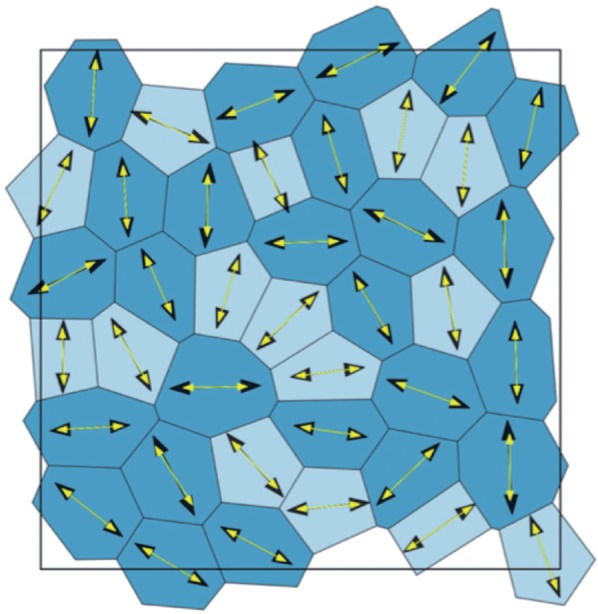
Computational validation of the predicted alignment between principal axis of stress and shape, for \documentclass[12pt]{minimal}
\usepackage{amsmath}
\usepackage{wasysym} 
\usepackage{amsfonts} 
\usepackage{amssymb} 
\usepackage{amsbsy}
\usepackage{upgreek}
\usepackage{mathrsfs}
\setlength{\oddsidemargin}{-69pt}
\begin{document}
}{}$(\Lambda, \Gamma) = (-0.2, 0.1)$\end{document}. The initial cell array was generated using a Voronoi tessellation and then relaxed to equilibrium using periodic boundary conditions. The eigenvectors corresponding the the principal eigenvalue of \documentclass[12pt]{minimal}
\usepackage{amsmath}
\usepackage{wasysym} 
\usepackage{amsfonts} 
\usepackage{amssymb} 
\usepackage{amsbsy}
\usepackage{upgreek}
\usepackage{mathrsfs}
\setlength{\oddsidemargin}{-69pt}
\begin{document}
}{}$\boldsymbol{\sigma}_{\alpha}$\end{document} and \documentclass[12pt]{minimal}
\usepackage{amsmath}
\usepackage{wasysym} 
\usepackage{amsfonts} 
\usepackage{amssymb} 
\usepackage{amsbsy}
\usepackage{upgreek}
\usepackage{mathrsfs}
\setlength{\oddsidemargin}{-69pt}
\begin{document}
}{}$\mathsf{S}$\end{document} are plotted in black and yellow, respectively. Darker cells have \documentclass[12pt]{minimal}
\usepackage{amsmath}
\usepackage{wasysym} 
\usepackage{amsfonts} 
\usepackage{amssymb} 
\usepackage{amsbsy}
\usepackage{upgreek}
\usepackage{mathrsfs}
\setlength{\oddsidemargin}{-69pt}
\begin{document}
}{}$P_{\alpha}^{\text{eff}} > 0$\end{document} (net tension); lighter cells have \documentclass[12pt]{minimal}
\usepackage{amsmath}
\usepackage{wasysym} 
\usepackage{amsfonts} 
\usepackage{amssymb} 
\usepackage{amsbsy}
\usepackage{upgreek}
\usepackage{mathrsfs}
\setlength{\oddsidemargin}{-69pt}
\begin{document}
}{}$P_{\alpha}^{\text{eff}} < 0$\end{document} (net compression). (Colour in online.)